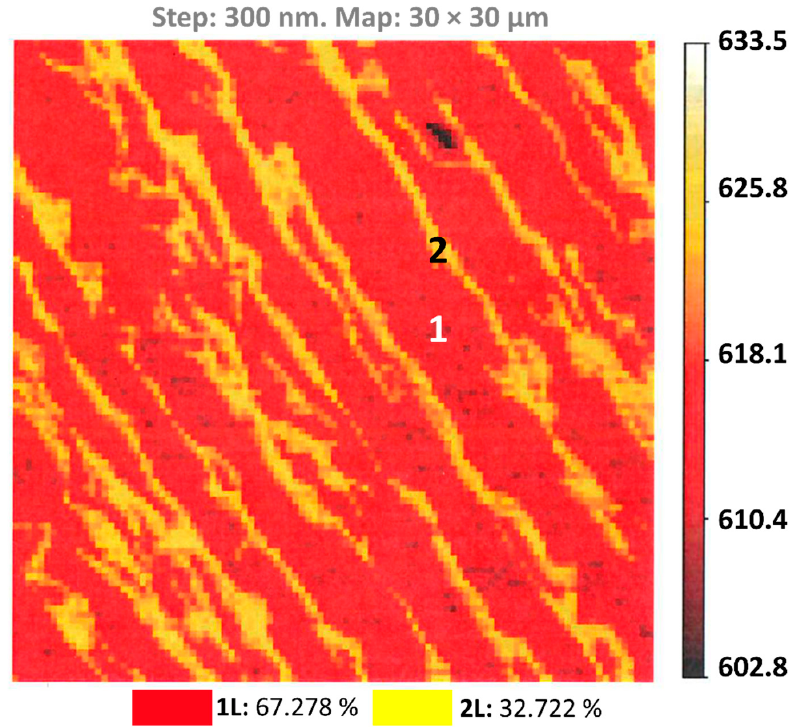
Figure 2. The optical reflectance map showing the co-existence of monolayer (marked by 1) and bilayer (marked by 2) epitaxial graphene regions on a 30 × 30 µ m 2 area.